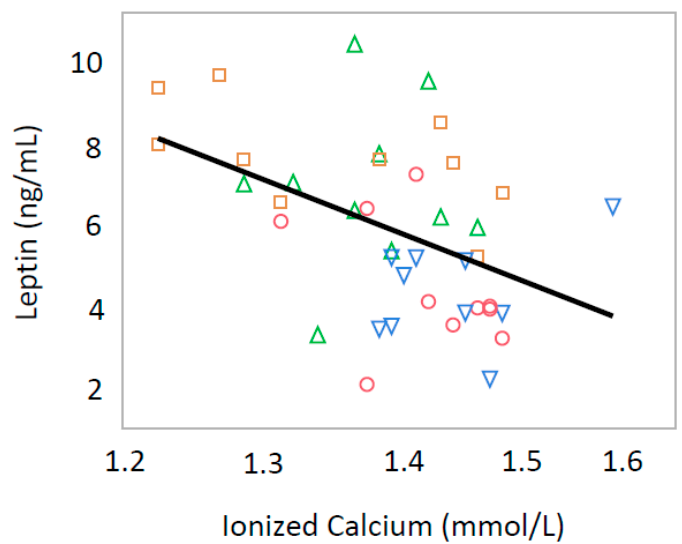
Figure 3. Relationship between serum ionized calcium and serum leptin levels in both male and female rat offspring (R = − 0.454, p = 0.0025). Green triangle, male offspring from control group; square, male offspring from Ca-deficient group; circle, female offspring from control group; blue inverse triangle, female offspring from Ca-deficient group.